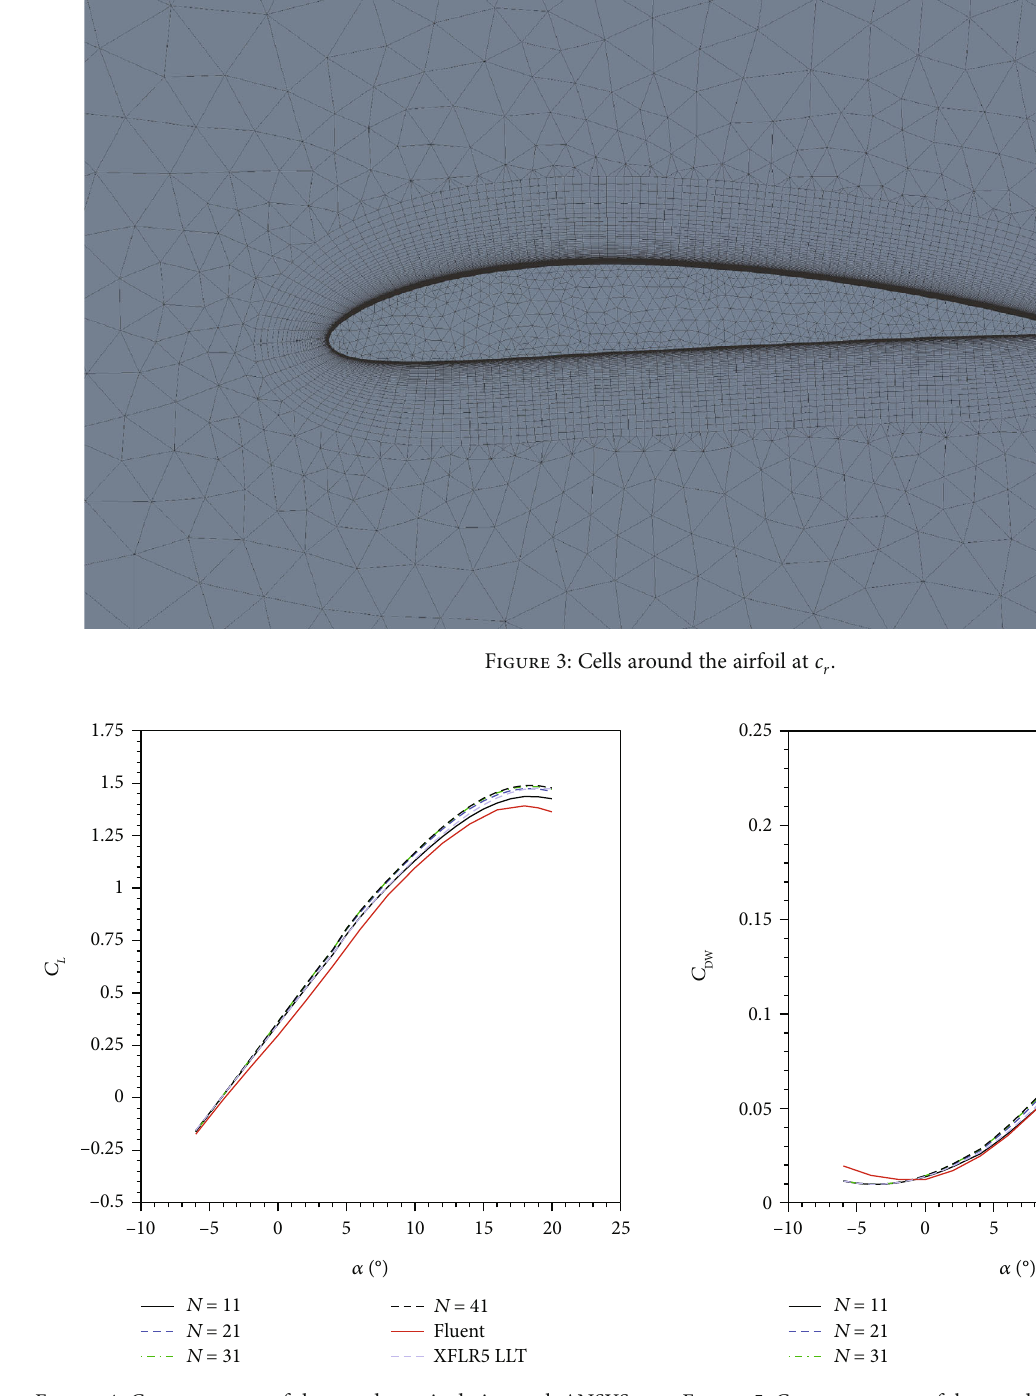
Figure 5: C vs. α curves of the aerodynamic design tool, ANSYS- Dw Fluent, and